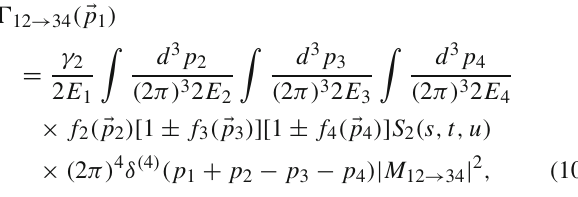
tern as the temperature T increases. When approaching T c